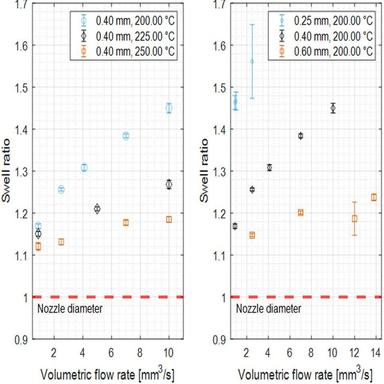
Swell ratio as a function of volumetric flow rate for the 0.40 mm nozzle orifice diameter at varying hot end temperature setpoints (left) and varying nozzle orifice diameters for a hot end temperature setpoint of 200 ◦C (right). The error bars represent one standard deviation of the swell ratio.